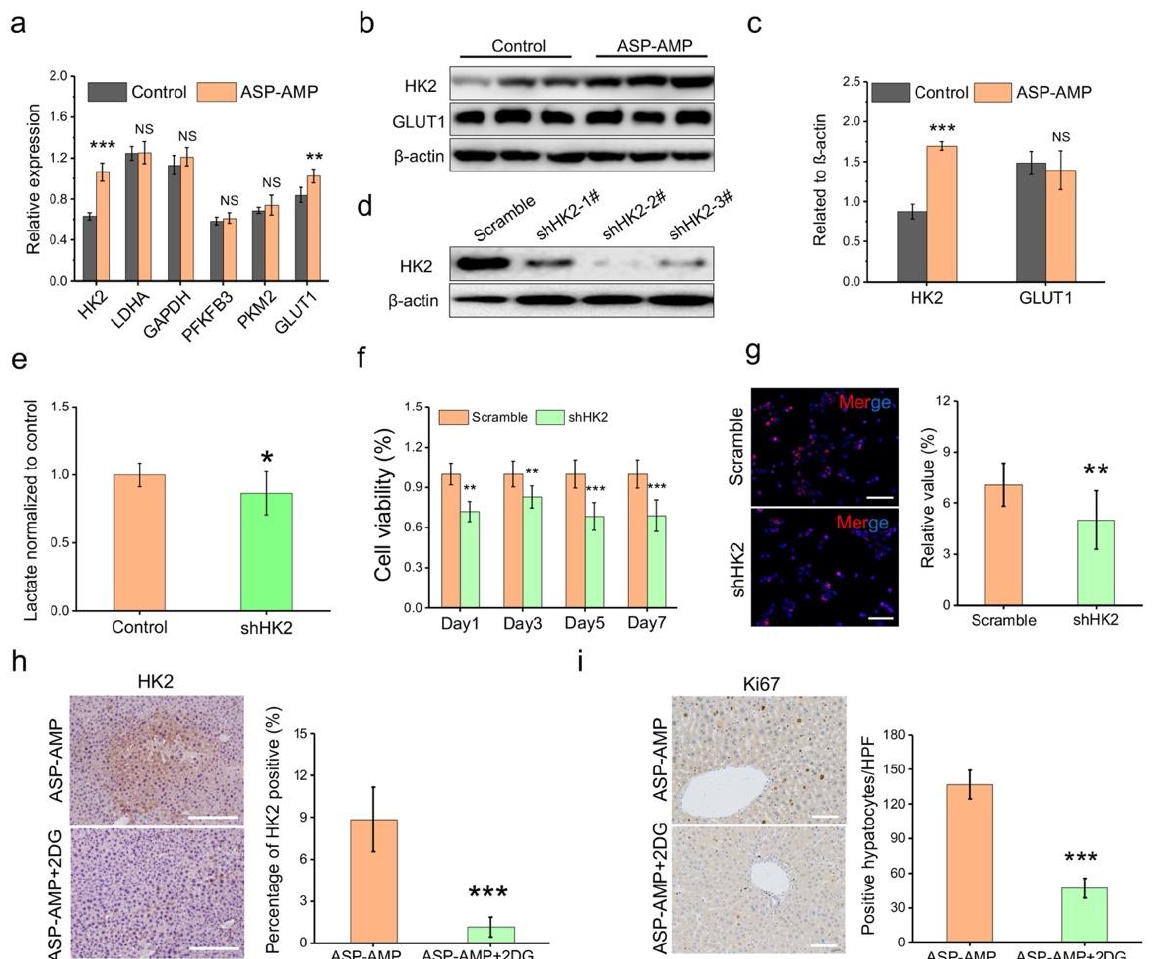
Figure 5. ASP-AMP accelerated the hexokinase 2 (HK2) involved glycolysis to promote liver regeneration. ( a ) RT-PCR analysis of rate-limiting enzymes related to glycolysis. ( b ) Western blot analysis for HK2 and GLUT1 after ASP-AMP treatment in NCTC clone 1469 cells ( n = 3). ( c ) Relative protein was quantitatively expressed by densitometric analysis and is shown as the fold change relative to β -actin. ( d ) Efficiency of knockdown of HK2 in NCTC clone 1469 cells. ( e ) Lactate levels in supernatant of HK2 knockdown NCTC clone 1469 cells ( n = 3). ( f ) The cell viability of HK2 knockdown NCTC clone 1469 cells treated with a combination of ASP and AMP for 7 days ( n = 3). ( g ) Click-iT EdU proliferation staining of HK2 knockdown NCTC clone 1469 cells treated with ASP-AMP for 3 days and the relative expression rates of positive EdU staining (Scale bar = 100 µ m). ( h ) Representative images of IHC staining for HK2 in the liver tissue of mice after hepatectomy when treated with ASP-AMP or ASP-AMP+2DG for 3 days and the analysis of percentage of HK2 positive area (Scale bar = 100 µ m). ( i ) Ki67 staining of liver sections with 3 days of ASP-AMP+2DG after hepatectomy and the quantification of positive cells (scale bar = 100 µ m). * p < 0.05, ** p < 0.01, and *** p < 0.001.